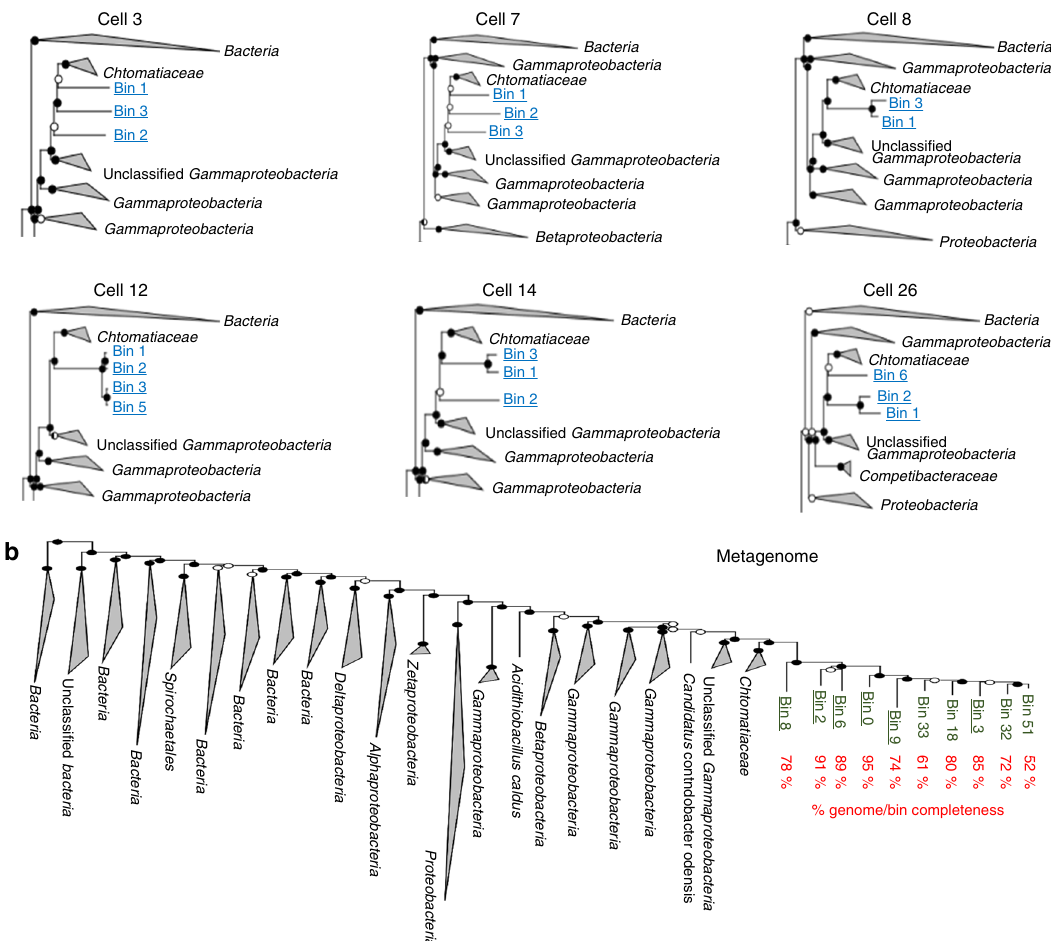
Fig. 4 Maximum likelihood trees calculated from concatenated sequences of conserved single copy marker genes. The genes were found in genes of the 6 sequenced single cells a and the different genomic bins of the Achromatium metagenome b